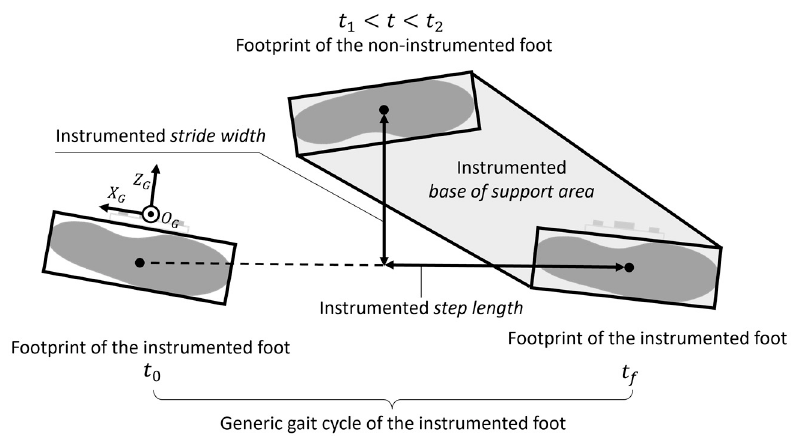
Figure 3. Base of support parameters associated with a generic gait cycle of the instrumented (right) foot. The instrumented base of support is the area surrounded by the outer edges of the footprint of the non-instrumented foot and the consecutive contralateral one. t 0 and t f are consecutive flat-foot instants of the instrumented foot. t 1 – t 2 is the portion of the flat-foot phase of the non-instrumented foot in which the distance sensors record inter-foot distances. The chosen global coordinate system (CS G ) for the considered gait cycle is the MIMU coordinate system at t 0 .